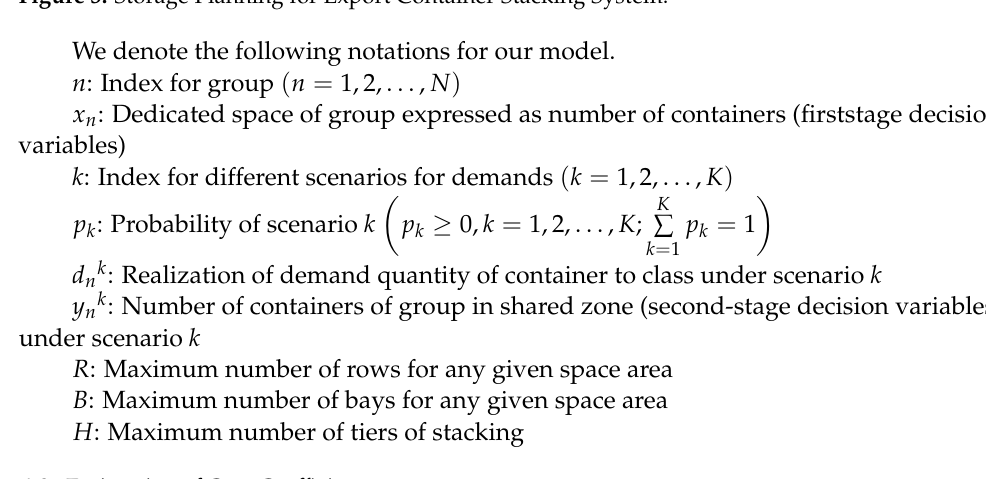
Figure 3. Storage Planning for Export Container Stacking System.